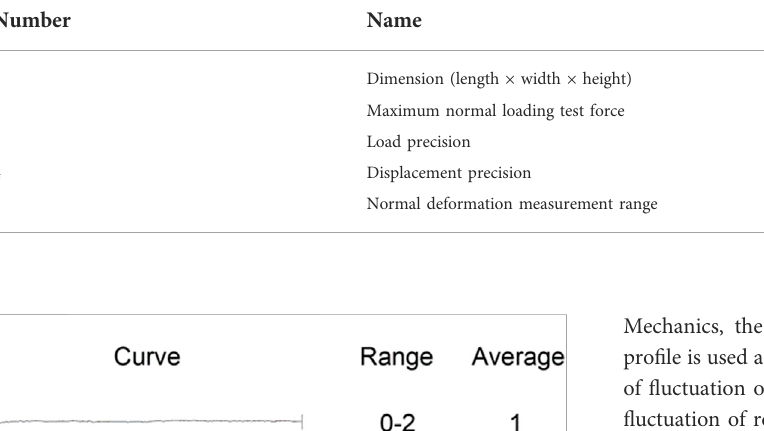
TABLE 1 Technical parameters of the multifunctional rock-soil contact damage test system.